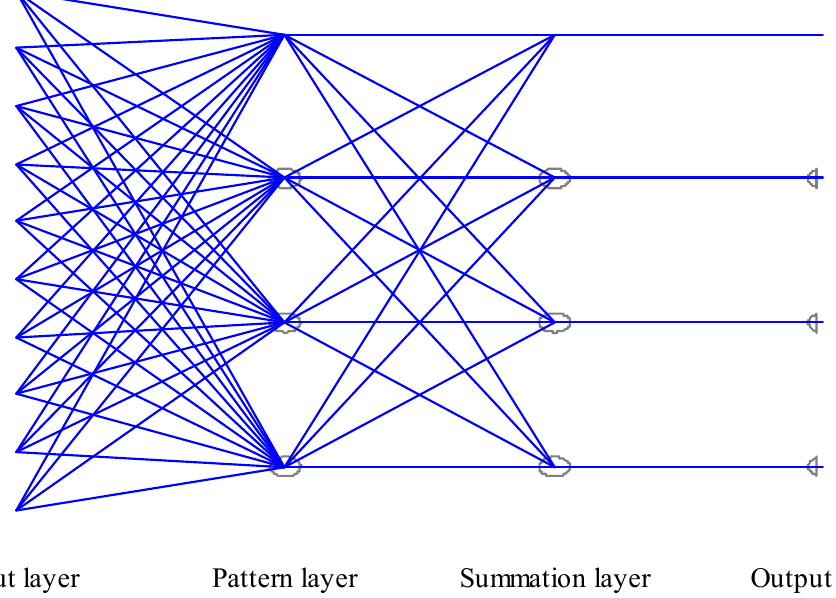
Figure 5. Structure of ANN model to classify oil samples from different extraction technologies as well as Alwana oil (traditionally extracted olive oil).